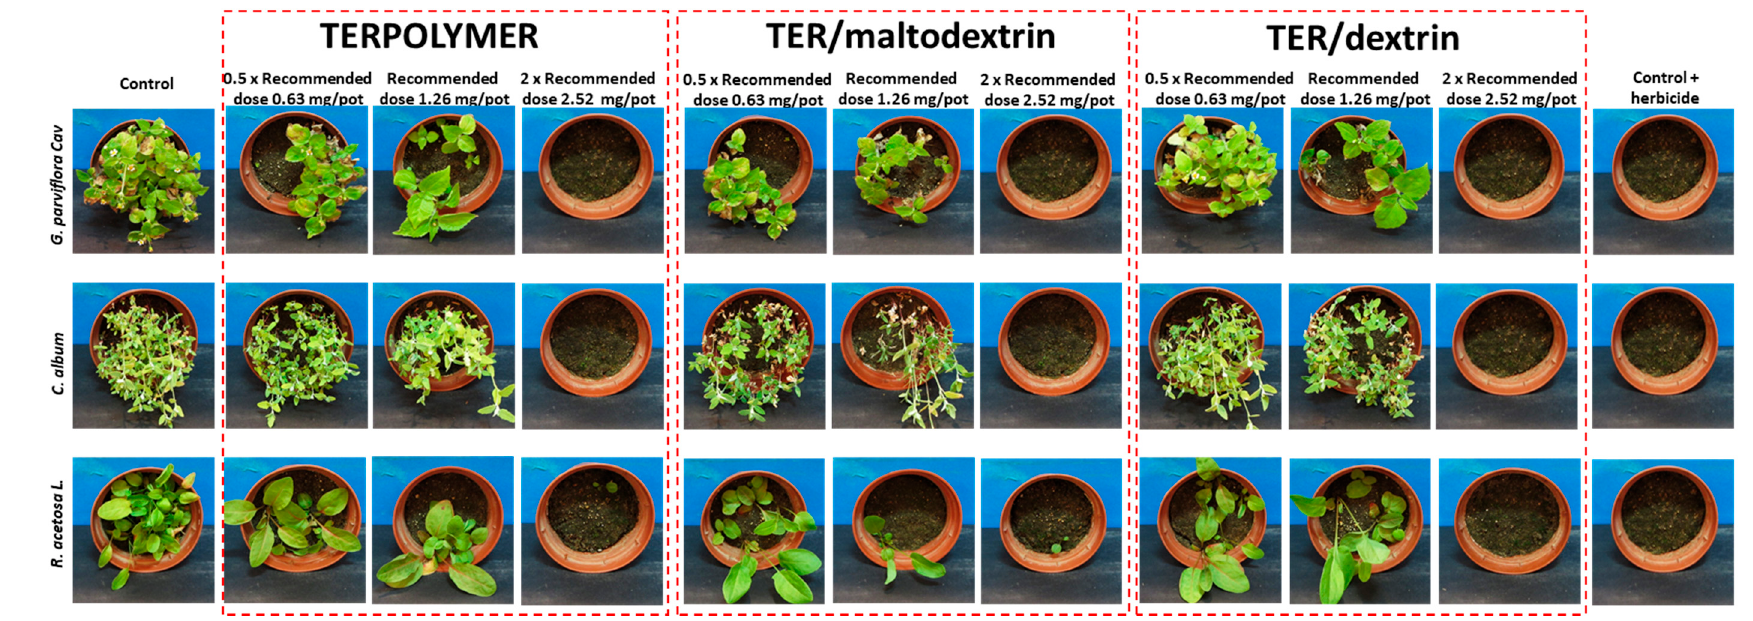
Figure 9. Herbicidal activity assessment of released pendimethalin from microspheres after one month of incubation of microspheres in soil. Table 3. Herbicidal activity assessment of pendimethalin released from microspheres after one month of their incubation in soil (EWRC scale). Herbicides were loaded in three doses: half of recommended (0.63 mg / pot), recommended (1.26 mg / pot) and double dose (2.52 mg / pot). TERPOLYMER TER/maltodextrin TER/dextrin